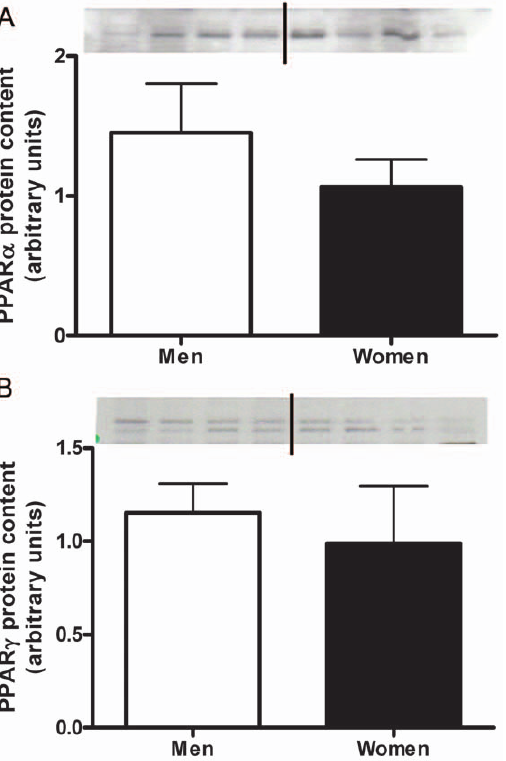
Figure 4. SCHAD protein content is equal in women and men. SCHAD mRNA content between men and women shown by Real time RT-PCR, adjusted to b 2-M mRNA (A). Protein content of SCHAD in skeletal muscle of men and women, adjusted to CS (B,C). Representative western blot (B) Lanes 1–4 are men, lanes 5–8 women. N=12 men and 11 women.